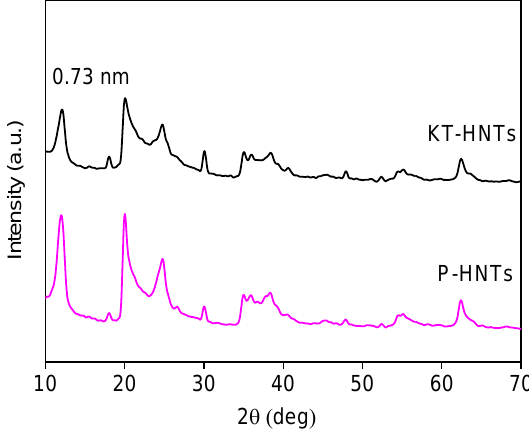
Figure 3. XRD diffraction patterns of P-HNTs and KT-HNTs.